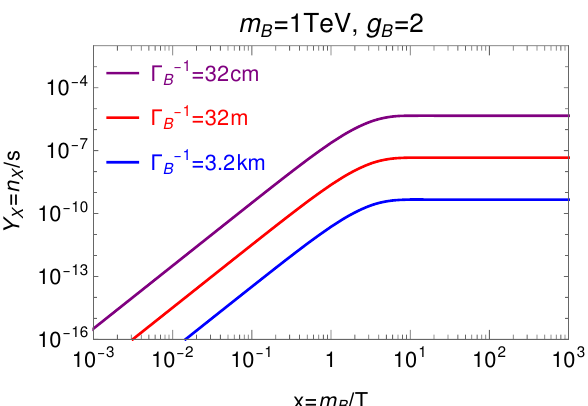
Figure 2. Freeze-in comoving number density from B decays for a Weyl fermion ( g B = 2